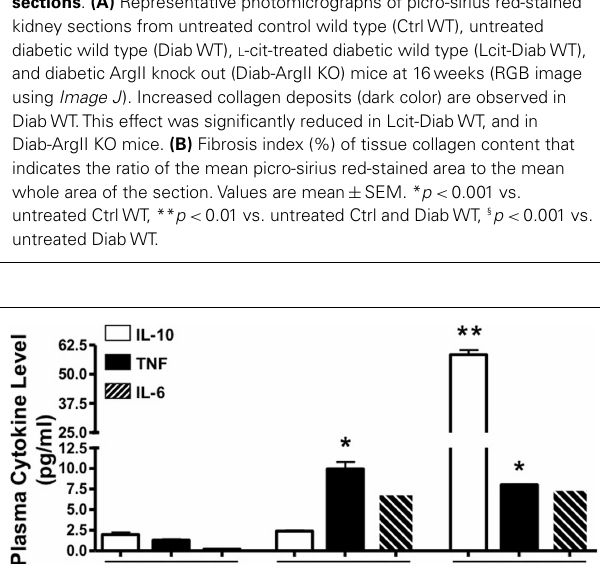
levels in both, untreated and l -cit-treated diabetic STZ-rats,